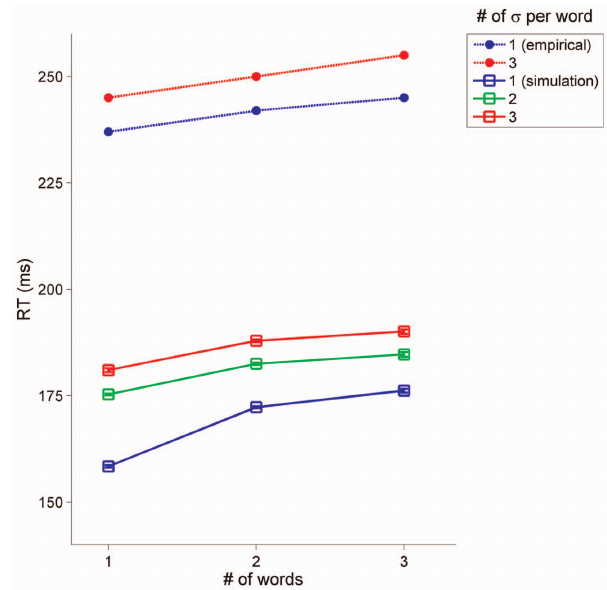
Figure 9. Dependence of RT on the number of words (utterance length) and the number of syllables per word (word complex- ity). The magnitudes of length and complexity effects are comparable in model simulations (squares) and empirical results